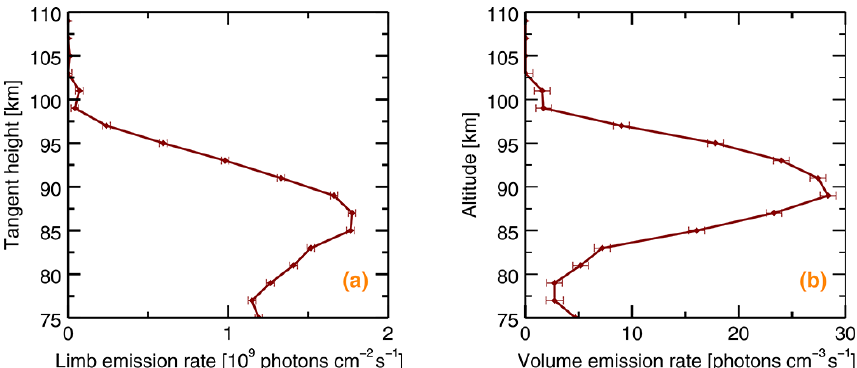
Figure 4. (a) Sample Na D-line nightglow LER profile for April 2004 determined from OSIRIS measurements. (b) Sample Na D-line nightglow VER profile that is obtained after inverting the LER profile that was obtained from OSIRIS measurements. It is assumed that there is no emission above 103km, so the VER over 103km is set to zero. The error bars represent the noise that is present in the spectra where no sodium signal is expected.